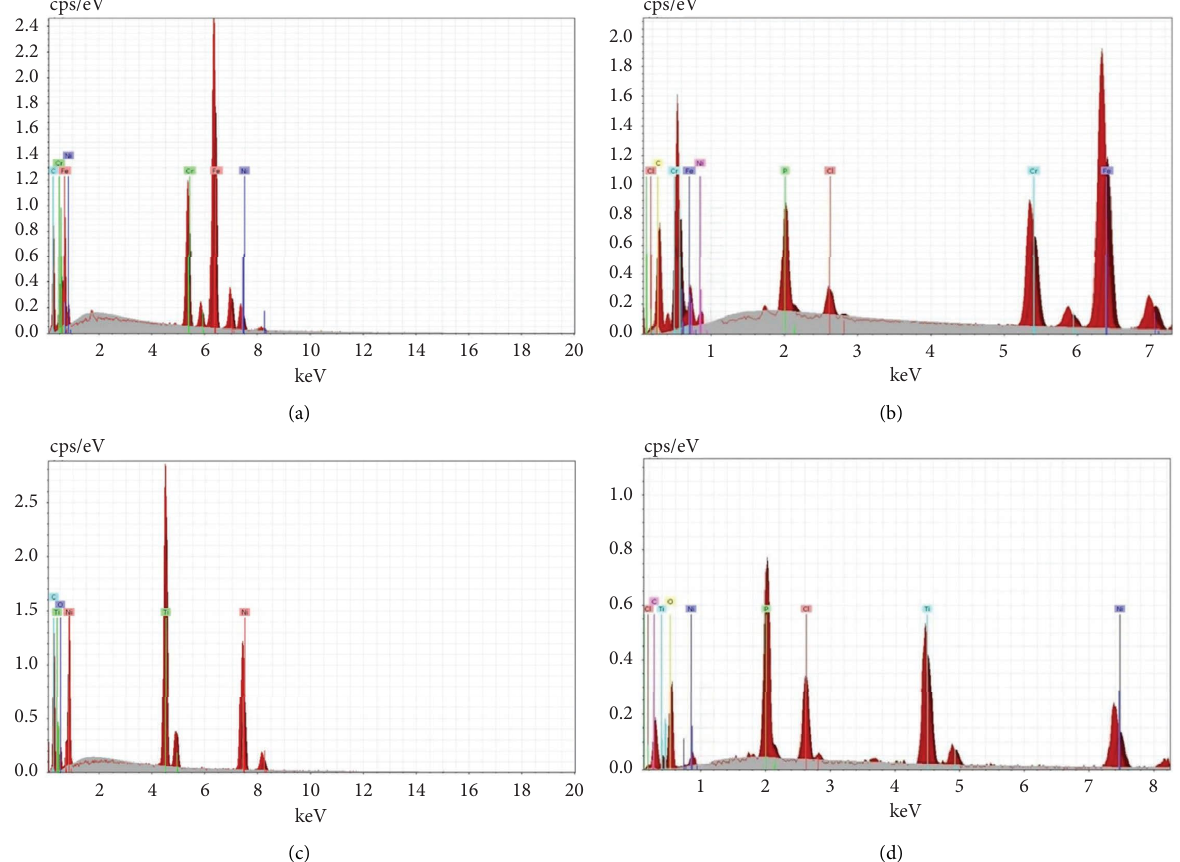
Figure 7: EDX charts for the examined SSW: ((a) before coating and (b) after coating) and the examined NiTiW ((c) before coating and (d) after